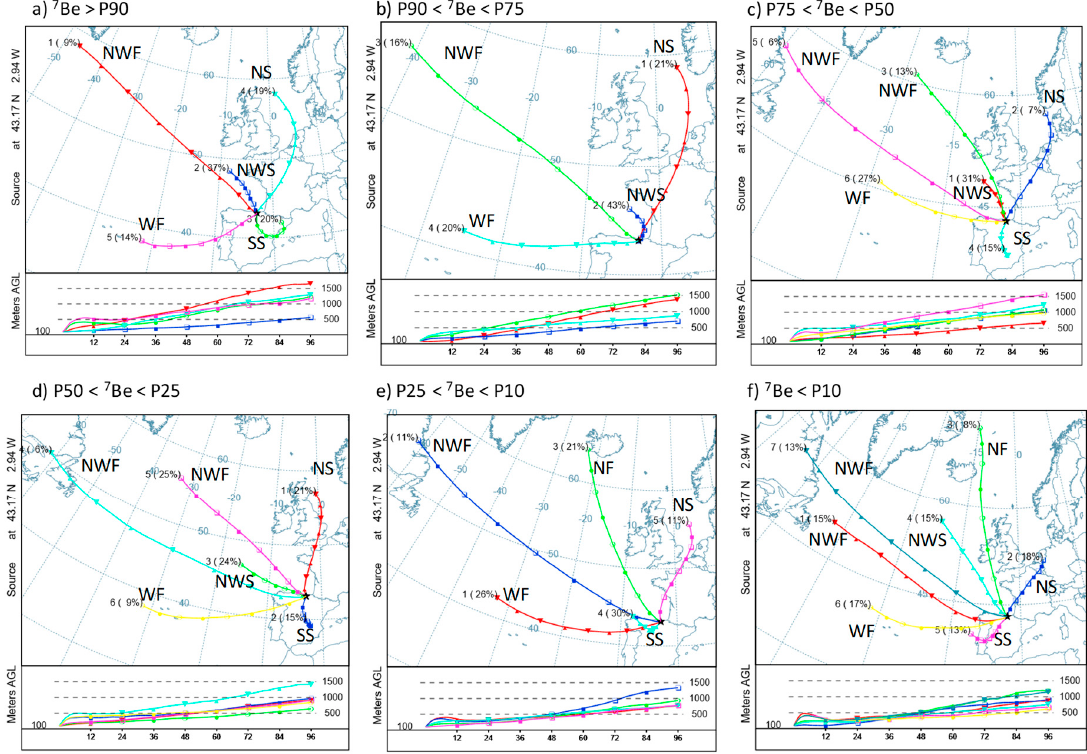
Figure 9. Back-trajectory cluster centers (centroids) were obtained at 100 m agl for the six 7 Be activity ranges at Bilbao. The left numbers in the centroids are an identification number of the centroid, and the right numbers (in brackets) are the percentage of complete trajectories occurring in that cluster.